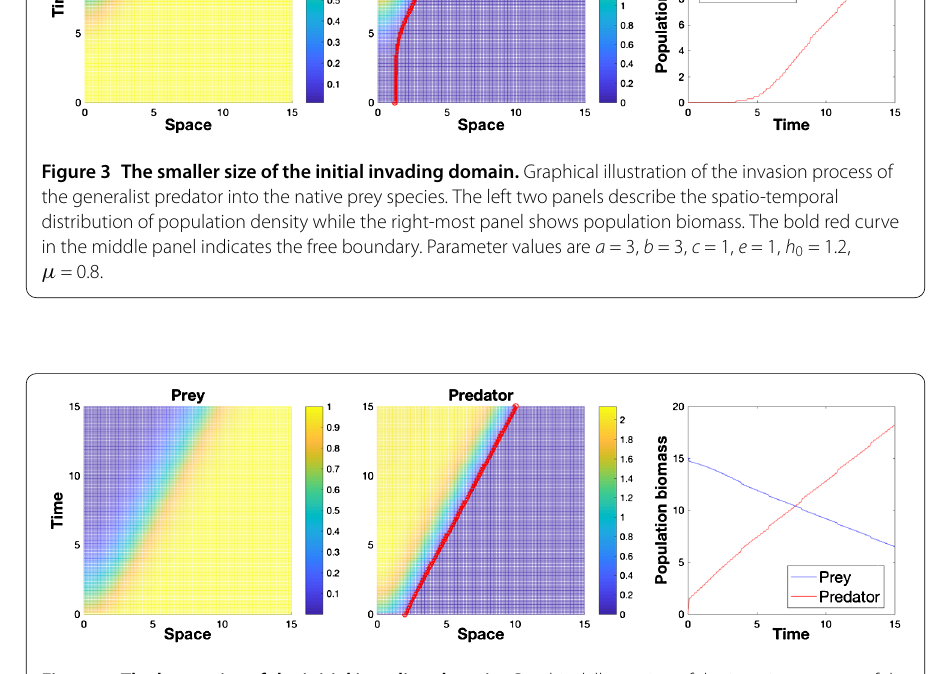
Figure 4 The larger size of the initial invading domain. Graphical illustration of the invasion process of the generalist predator into the native prey species. The left two panels describe the spatio-temporal distribution of population density while the right-most panel shows population biomass. The bold red curve in the middle panel indicates the free boundary. Parameter values are a = 3, b = 3, c = 1, e = 1, h 0 = 2, μ =